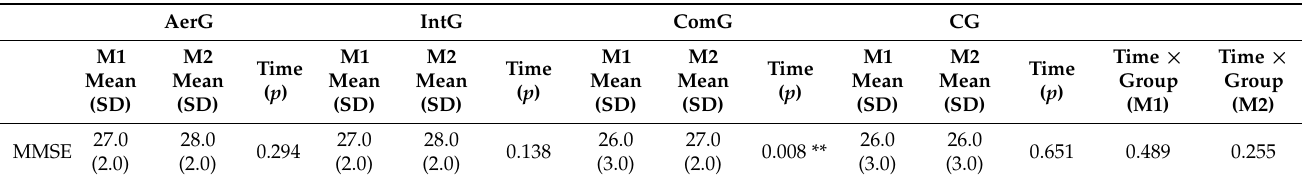
Table 4. Cognitive function results variation analysed by type of aquatic exercise program before and after intervention. AerG IntG ComG CG